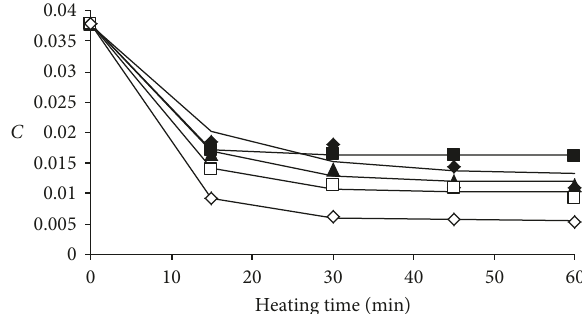
50 ° C, 70 ° C, 90 ° C, 100 ° C, 110 ° C, and ∆ 120 ° C). ◆ ■ ▲ □ ◇